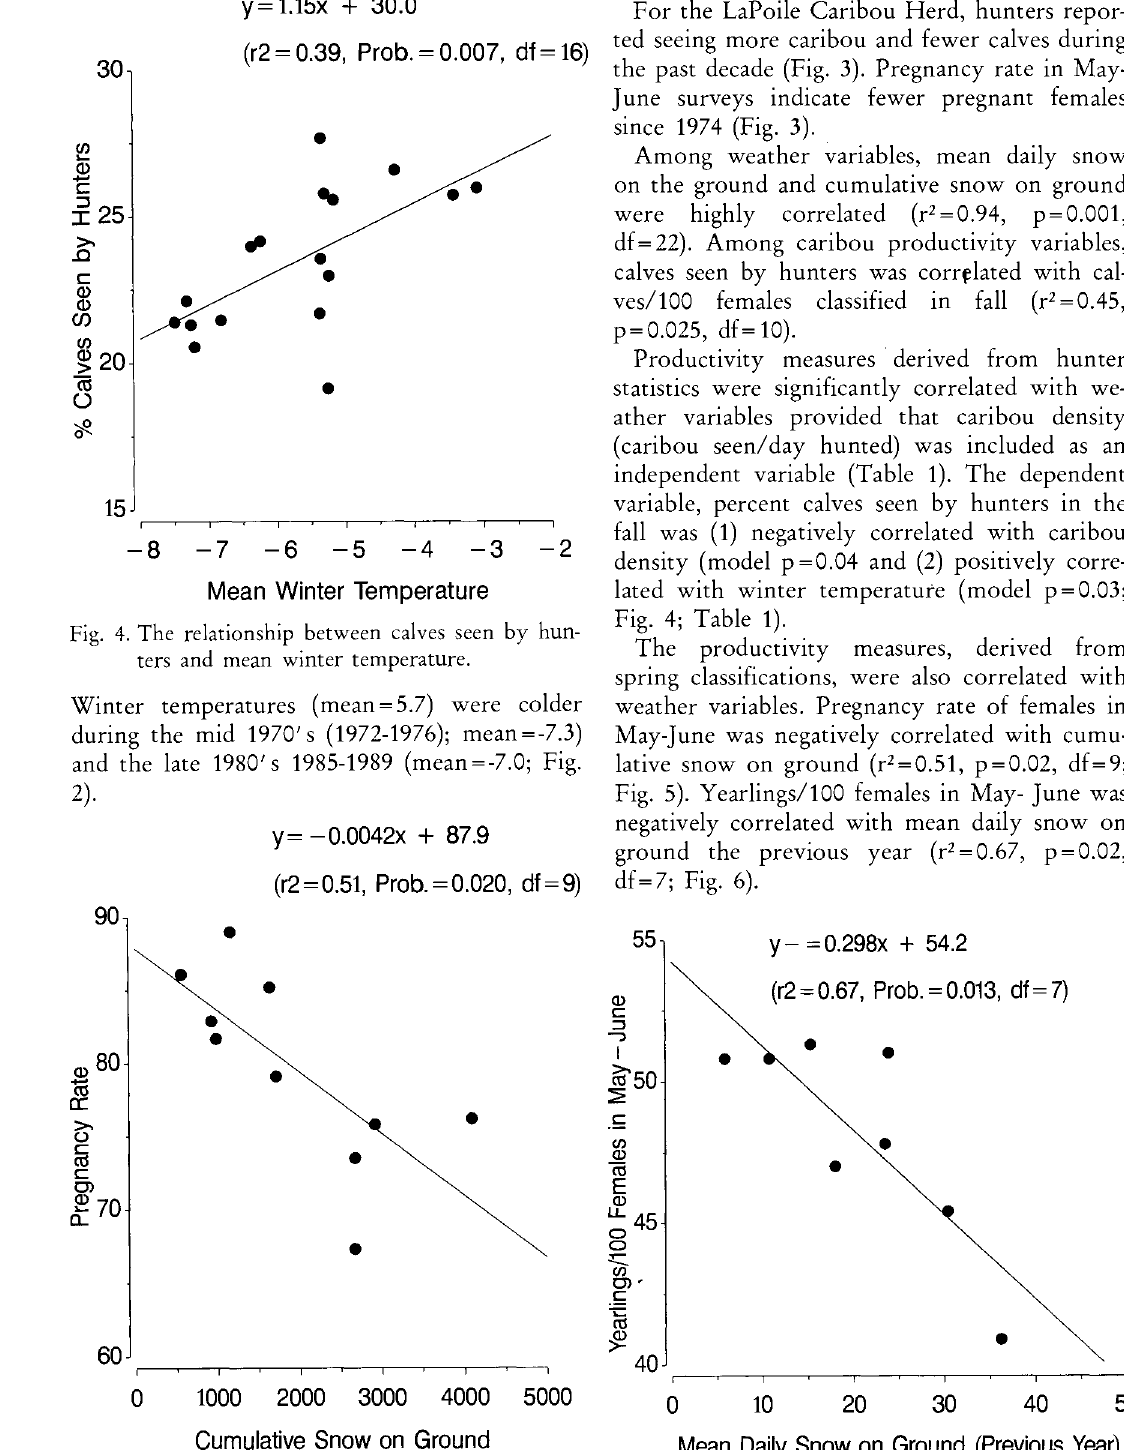
Fig. 6. The relationship between yearlings/100 fema les in spring and mean daily snow on the gro und (cm) the previous